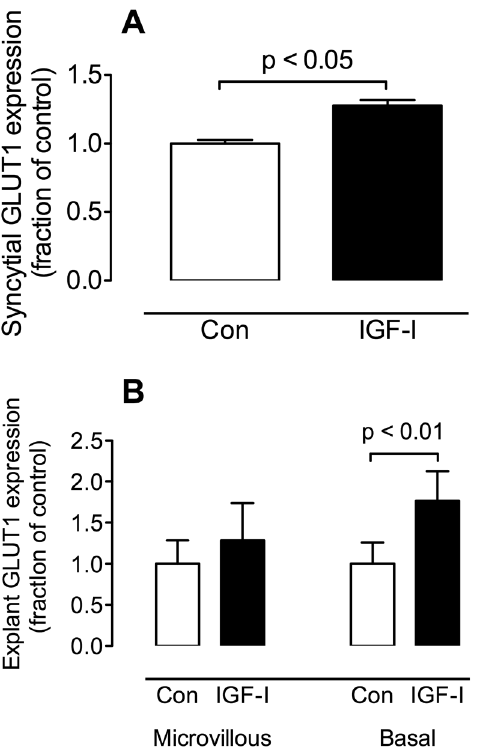
Figure 3. IGF-I and GLUT1 expression in primary syncytial cells and placental explants. (A) Syncytial cells : Serum-starved syncytial cells were treated for 24 hr. with 200 ng/mL IGF-1. GLUT1 measurement in cell extracts by slot blotting showed a significant increase as a result of IGF-I treatment (p , 0.05, paired t test, n=4). (B) Explants : Placental explants were serum-starved for 3 hr. then incubated with 200 ng/mL for 18 hr. Following incubation the explants were processed to produce microvillous and basal membrane fractions. GLUT1 was measured in these fractions by slot blotting. There was no change in microvillous membrane GLUT1 content as a result of IGF-I treatment however there was a substantial increase in GLUT1 in the basal membrane fraction (p , 0.01, paired t test, n=6). (Figure 3A) show that IGF-I treatment increased syncytial expression of GLUT1 (p , 0.05, paired t test, n =4). IGF-I and GLUT1 expression in placental explants We compared GLUT1 expression in syncytial microvillous and basal membranes prepared from explants which had been incubated in the presence or absence of IGF-I (200 ng/ml) for 18 hr. Figure 3B shows the results of Western blotting analyses for GLUT1 in explant microvillous and basal membrane fractions. GLUT1 protein expression in microvillous membranes from IGF- I-treated explant preparations was not different from that in control explants. Analysis of basal membrane fraction GLUT1 however revealed that IGF-I treated explants displayed GLUT1 levels that were significantly greater than the comparable, untreated membrane fraction (p , 0.01, paired t test, n = 6). Placental perfusion - glucose transfer